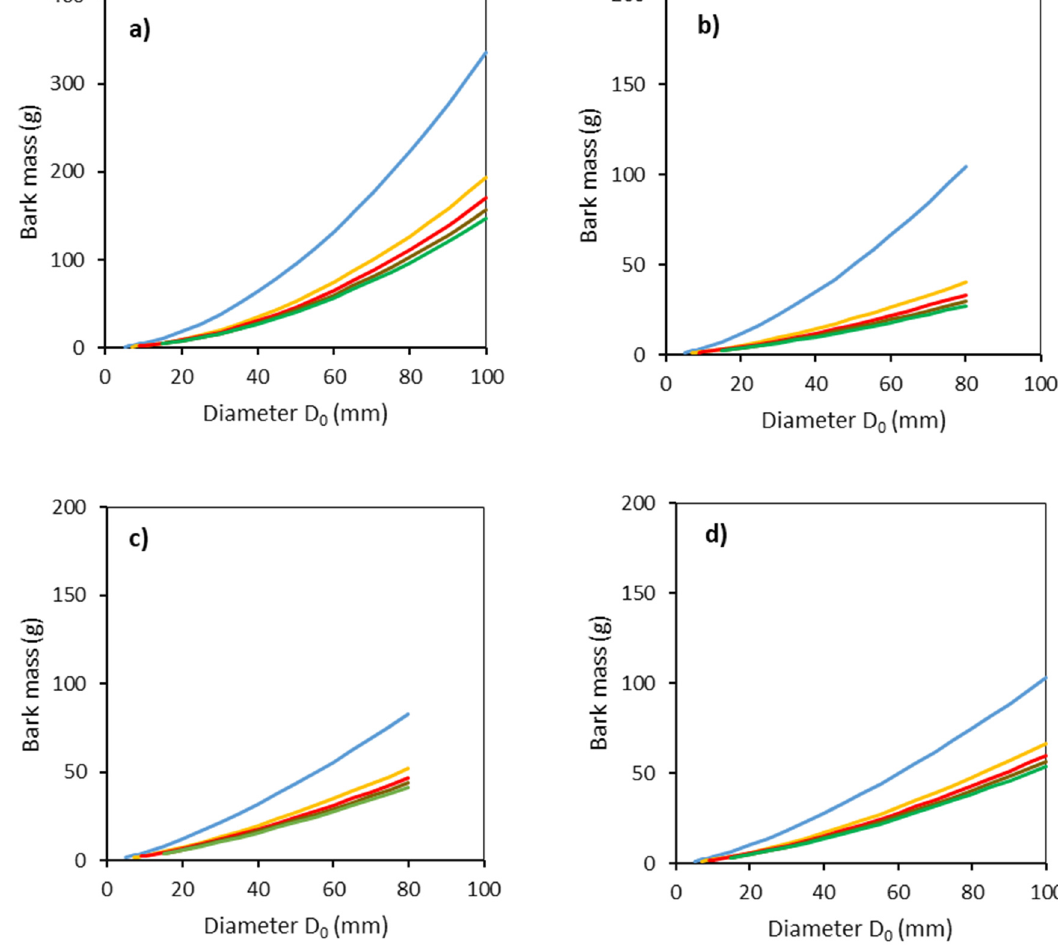
Figure 5. Modeled relationships between bark mass and stem base diameter D 0 for common aspen ( a ), goat willow ( b ), rowan ( c ) and sycamore ( d ), in separate stem sections defined by the distance from the ground level (blue: 0–50 cm, orange: 51–100 cm, red: 101–150 cm, brown: 151–200 cm, green: 201–250 cm) using Equation (6) and modeled stem radii (Equation (5) and Table 3).